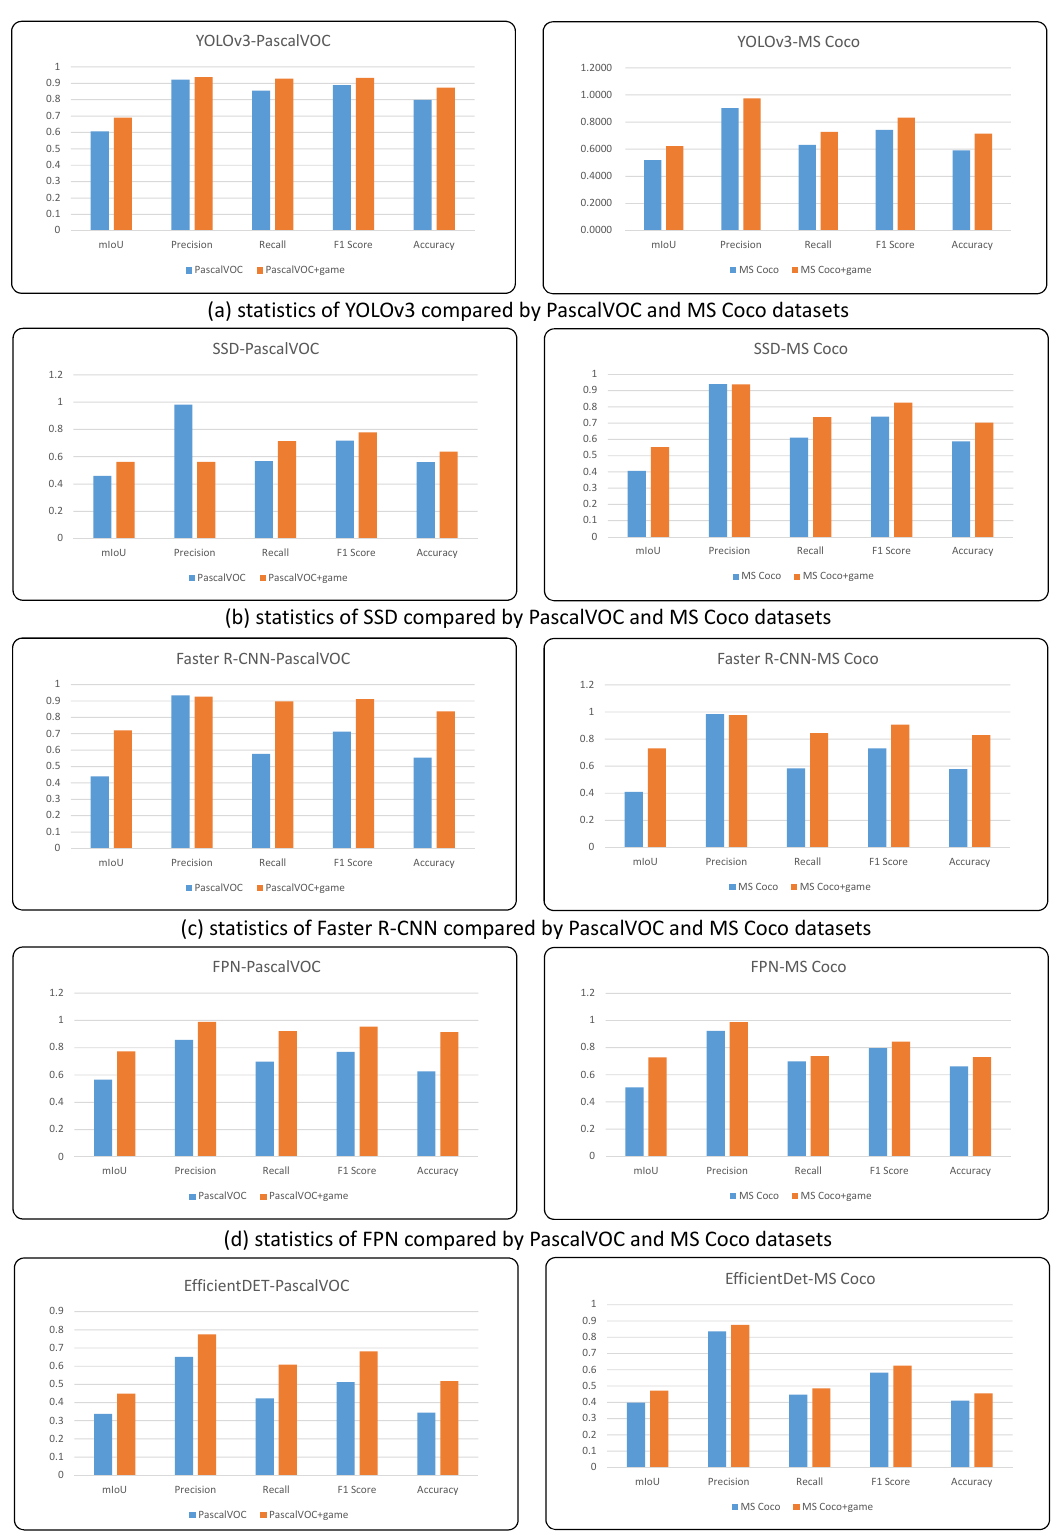
(e) statistics of EfficientDET compared by PascalVOC and MS Coco datasets Figure 5. Mean IoU, precision, recall, F1 score and accuracy are compared between two different datasets. In the left column, blue bars denote the values from those models trained using PascalVOC only and red bars are for PascalVOC + game scenes. In the right column, blue bars denote the values from those models trained using MS COCO only and red bars are for MS COCO + game